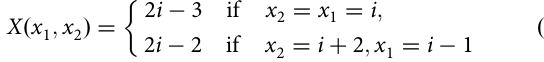
[Fig. 1b]. Their effective couplings come in two types: (i) dashed asymmetric couplings representing physical 2-body couplings